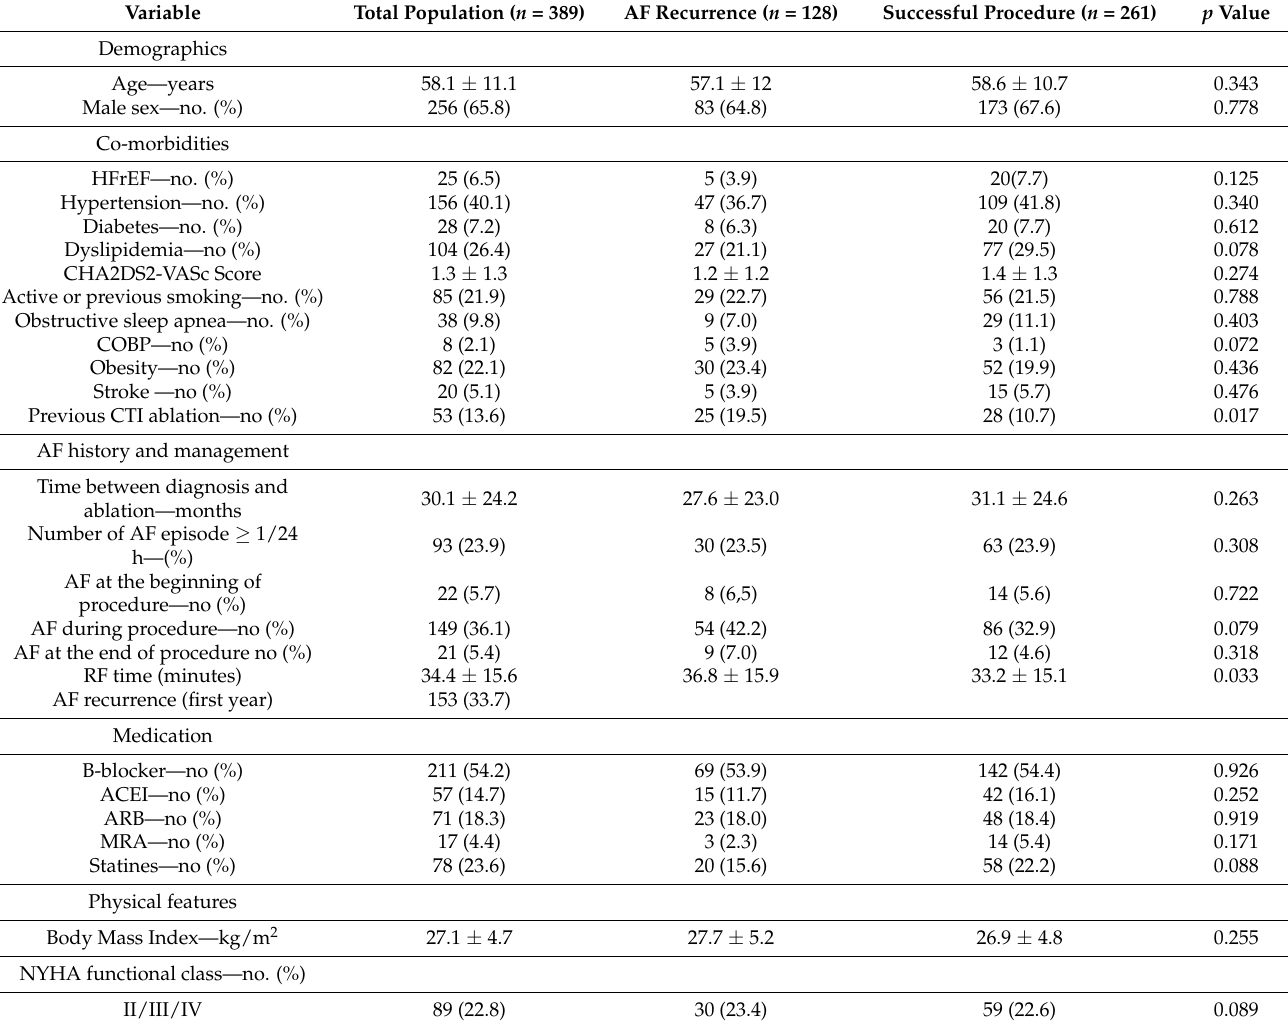
Table 1. Baseline data of the overall study cohort and 1-year-follow-up (divided into patients with and without AF recurrence during